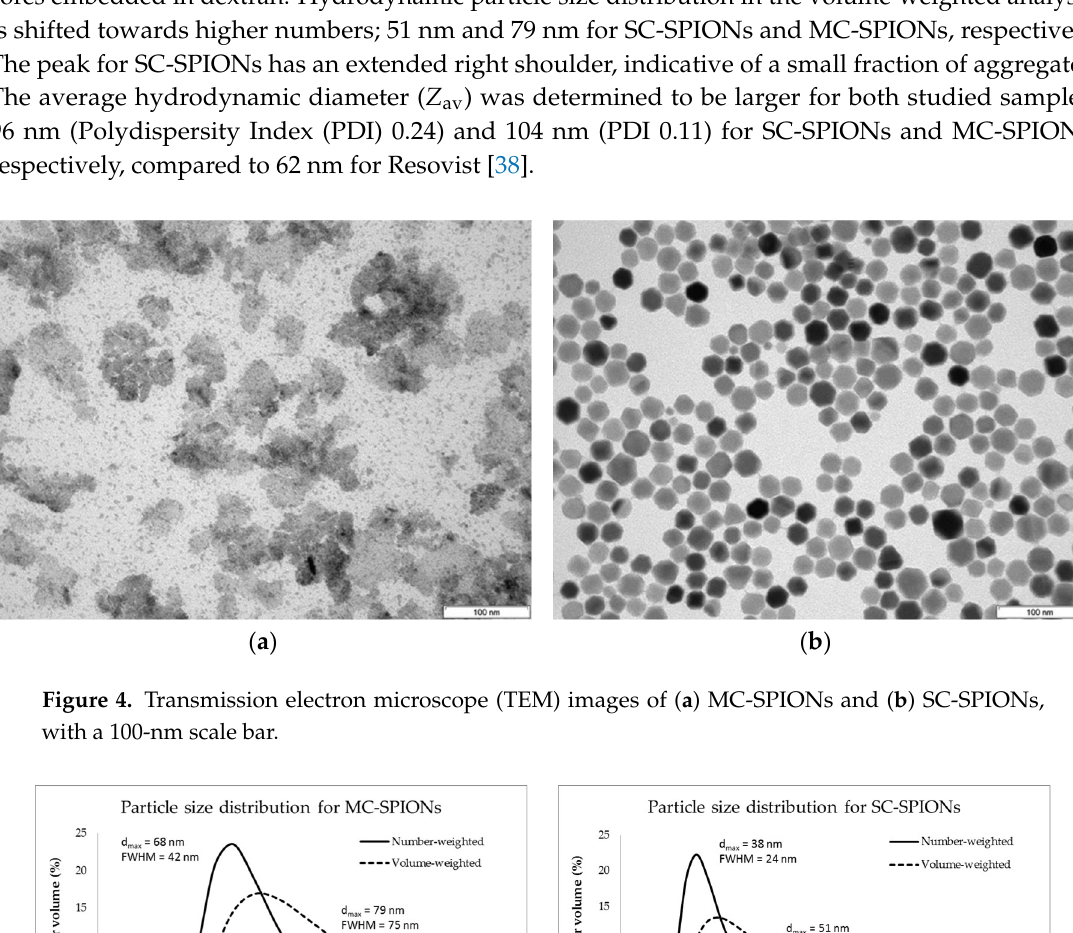
Figure 5. Hydrodynamic particle diameter distribution weighted by number (solid lines) and volume (dashed lines) measured by dynamic light scattering (DLS) for ( a ) MC-SPIONs and ( b ) SC-SPIONs. d max is the diameter corresponding to the maximum of the peak. FWHM stands for the full width at half maximum of the peak.